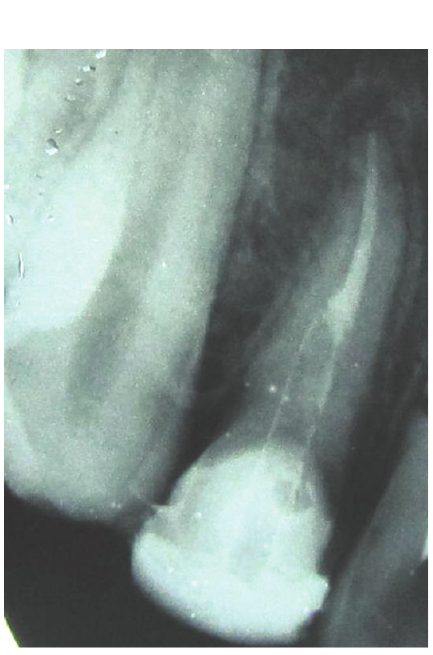
Figure 7: Post and core